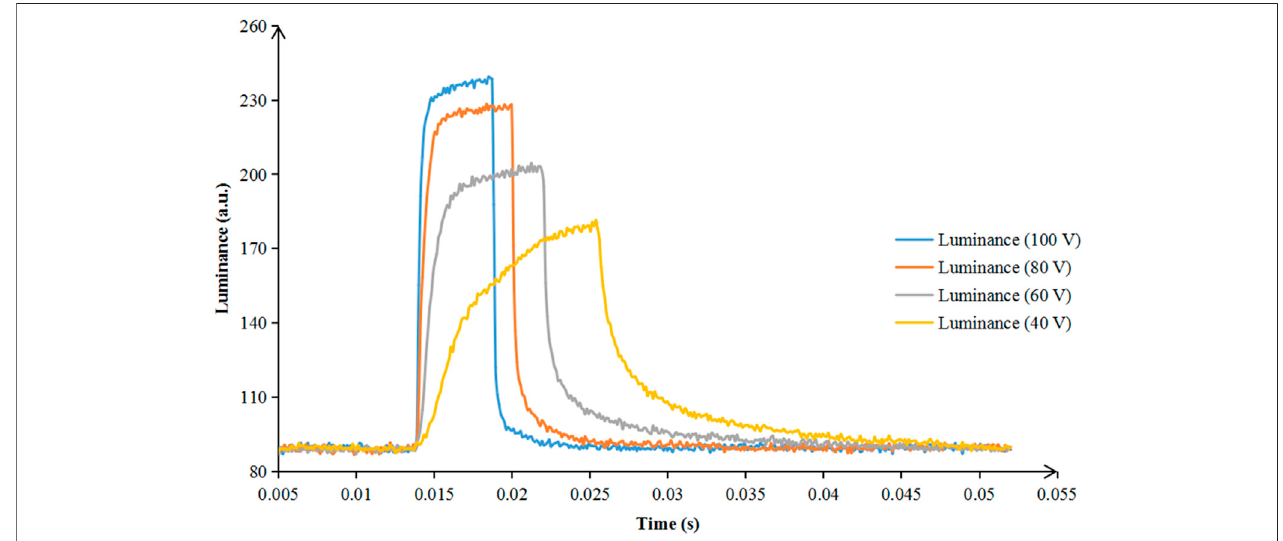
FIGURE 9 | Comparison of oil fi lm opening time among different voltages with equivalent driving constraints. The larger the driving voltage, the steeper the rising edge of the response curve.